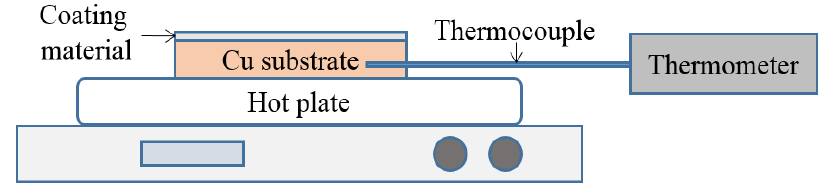
Figure 2. Schematic of the experiment for measurement of internal temperature of Cu substrate using a hot plate.